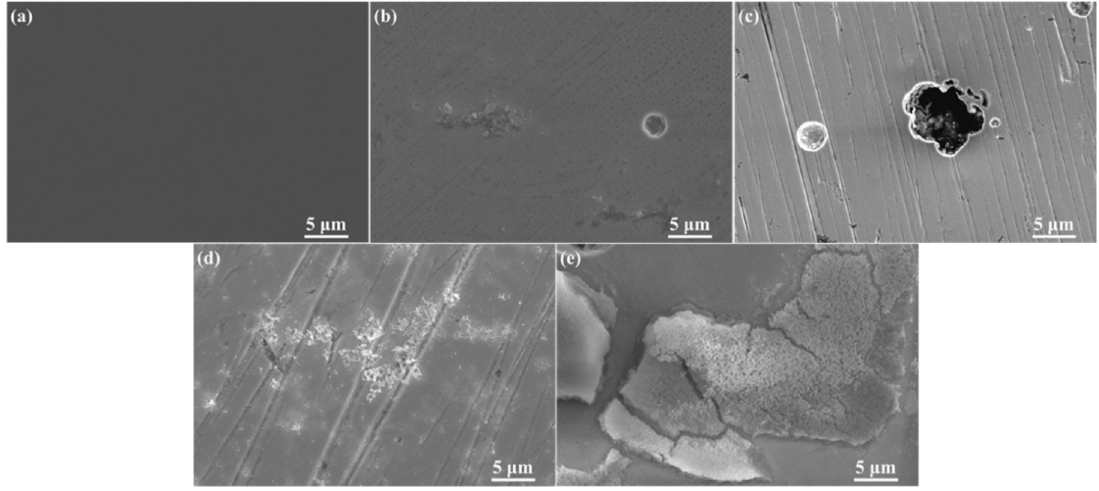
Figure 2. The SEM images of 304 stainless steel treated by polarization measurement in different solutions: ( a ) nontreated; ( b ) SG; ( c ) SG + CaCl 2 ; ( d ) SG + Na 2 CO 3 ; ( e ) SG + Na 2 SiO 3 .